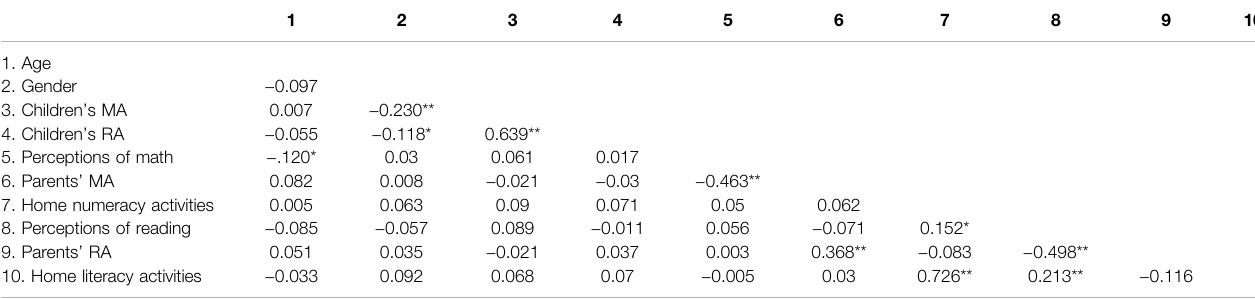
TABLE 3 | Correlations among control variables, HLE factors and children ’ s non-cognitive